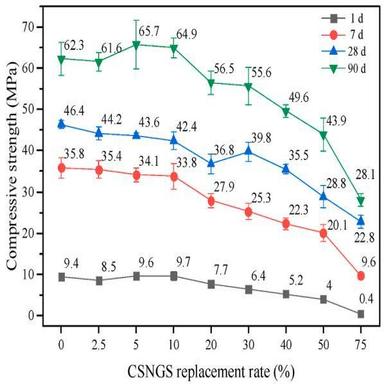
The compressive strength of composite paste with different curing age.